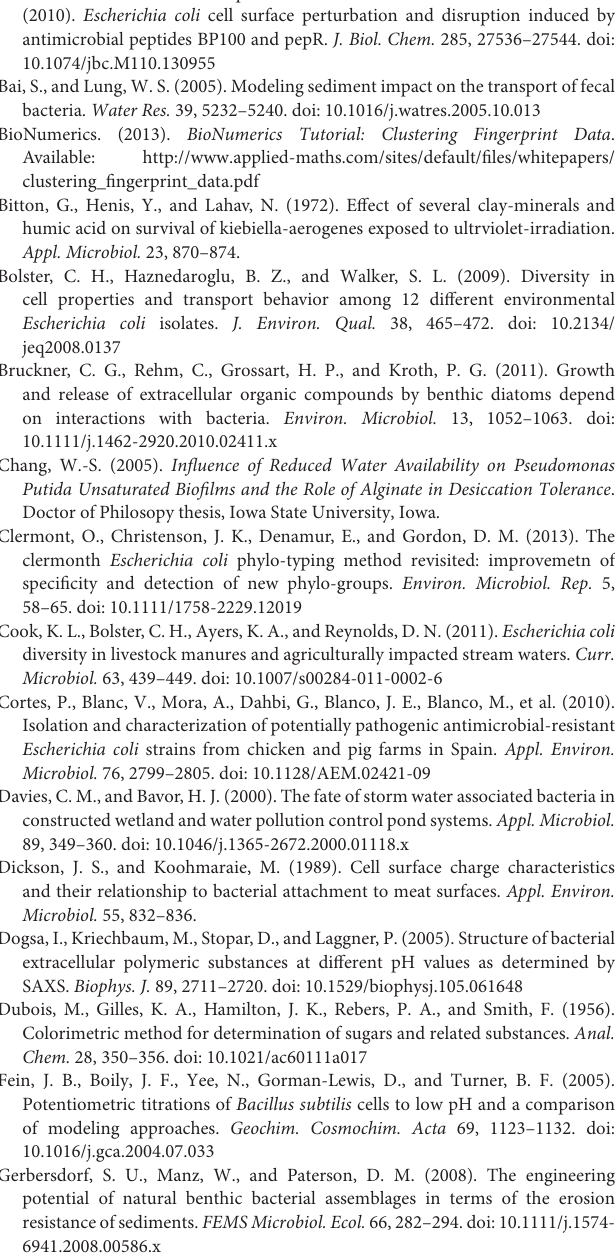
FIGURE A1 | Potentiometric titration curve example from strain number 53. Three pieces of information can be obtained from the curve: (1) Point of zero